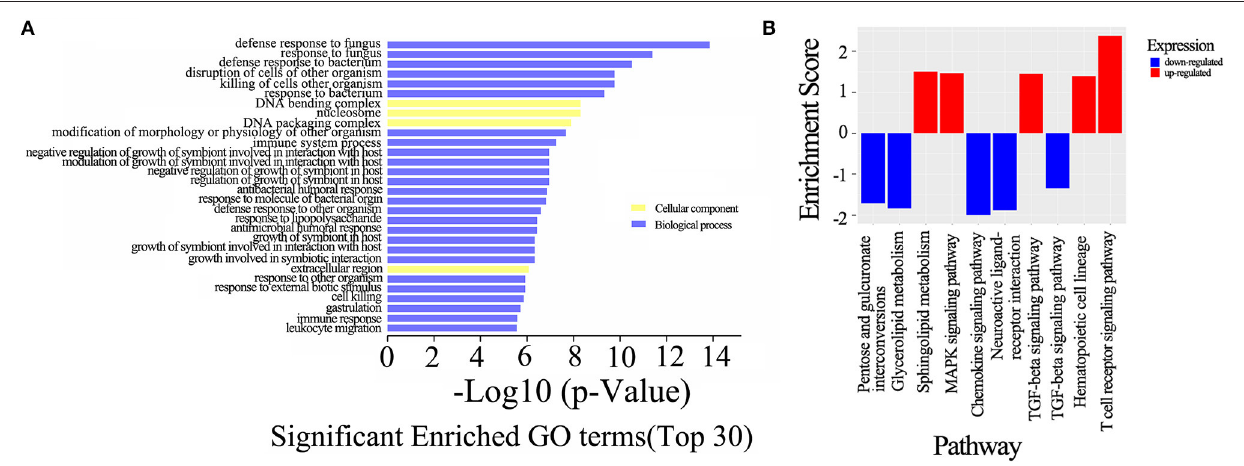
FIGURE 7 | GO and KEGG pathway analysis of the dysregulated mRNAs. (A) The top 30 GO terms that were enriched among the differentially expressed mRNAs in the comparison of the neurosyphilis patients with the healthy controls. The enrichment score was calculated using the P -value; the higher the score is, the more specific the corresponding function will be. (B) KEGG pathway analysis of deregulated mRNAs in the comparison of the neurosyphilis patients with the healthy controls. The red column indicates up-regulated expression, and the blue column indicates down-regulated expression. The enrichment score was calculated using the P- value; the higher the score is, the more specific the corresponding function will